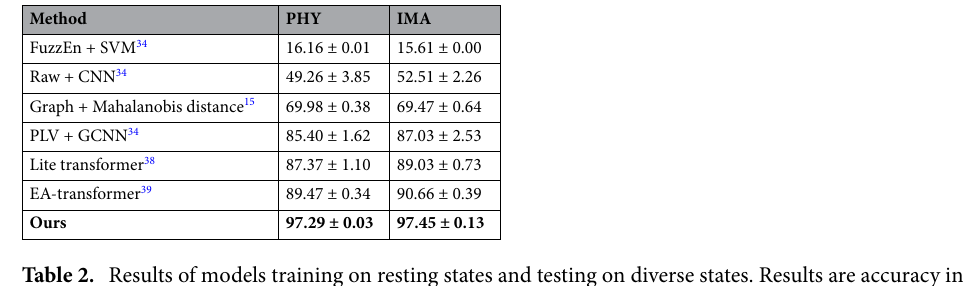
Table 2. Results of models training on resting states and testing on diverse states. Results are accuracy in testing stage (average ± standard deviation)%. Significant values are in [bold].